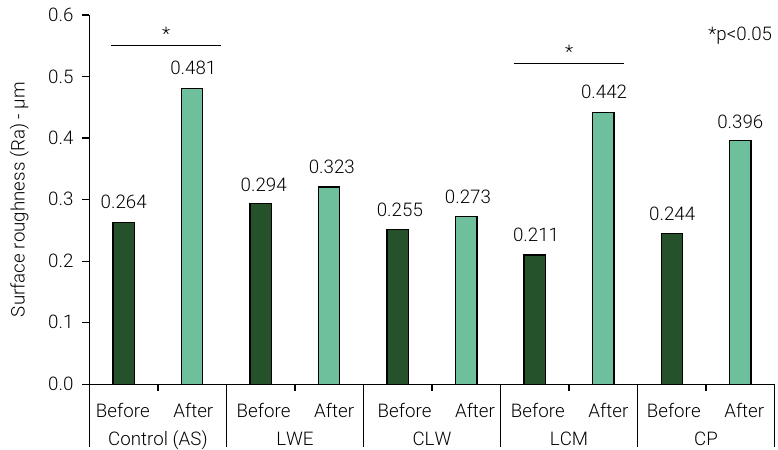
Figure 3. Color change (∆E*) of the nanocomposite Filtek Z350 after application protocol in whitening and conventional mouth